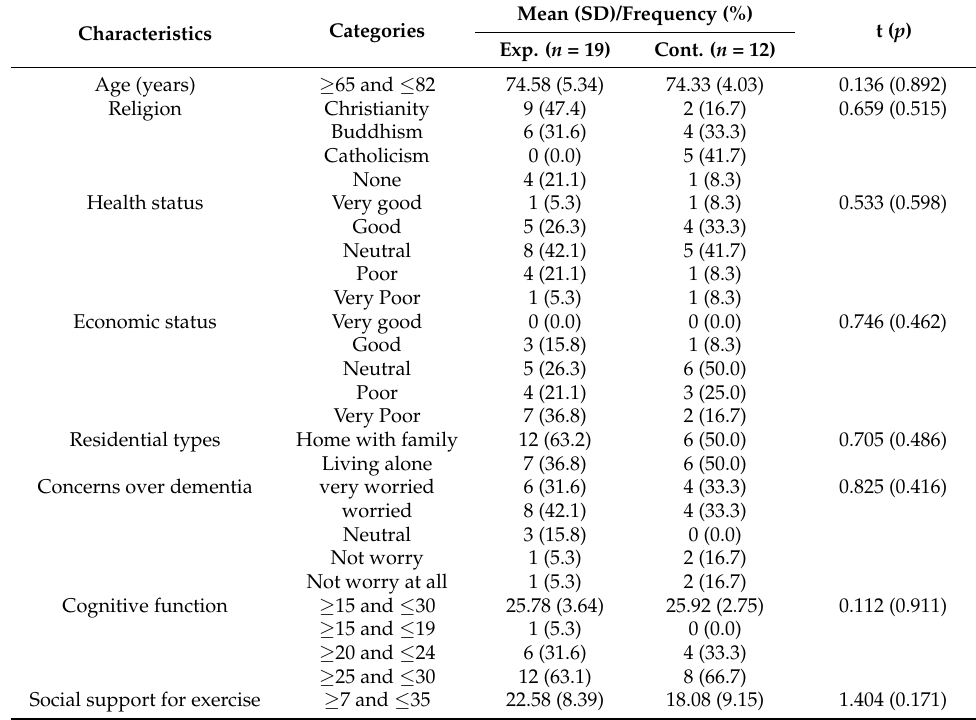
Table 1. Homogeneity of the preliminary